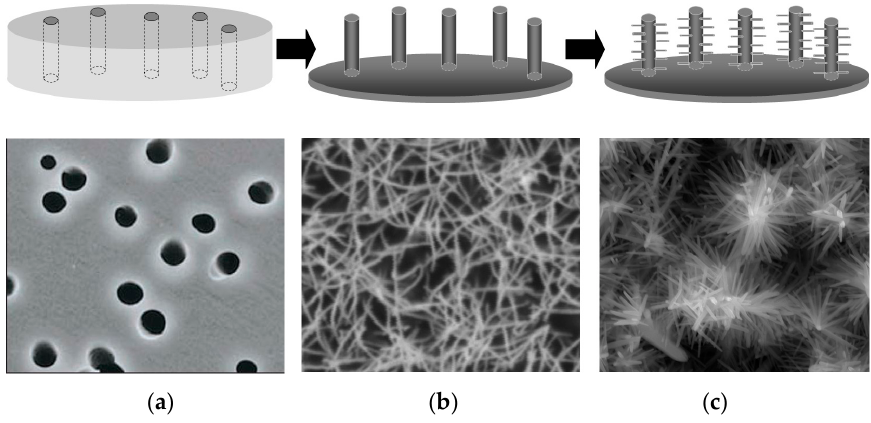
Figure 5. Scheme illustrating the preparation procedure used to obtain Au nanowires decorated with hierarchically branched ZnO. ( a ) scheme and SEM image of the template membrane; ( b ) scheme and SEM image of an ensemble of gold nanowires obtained by electroless deposition; ( c ) scheme and SEM image of ZnO nanostructures grown electrochemically on the Au nanowires (reprinted with permission from [55]).